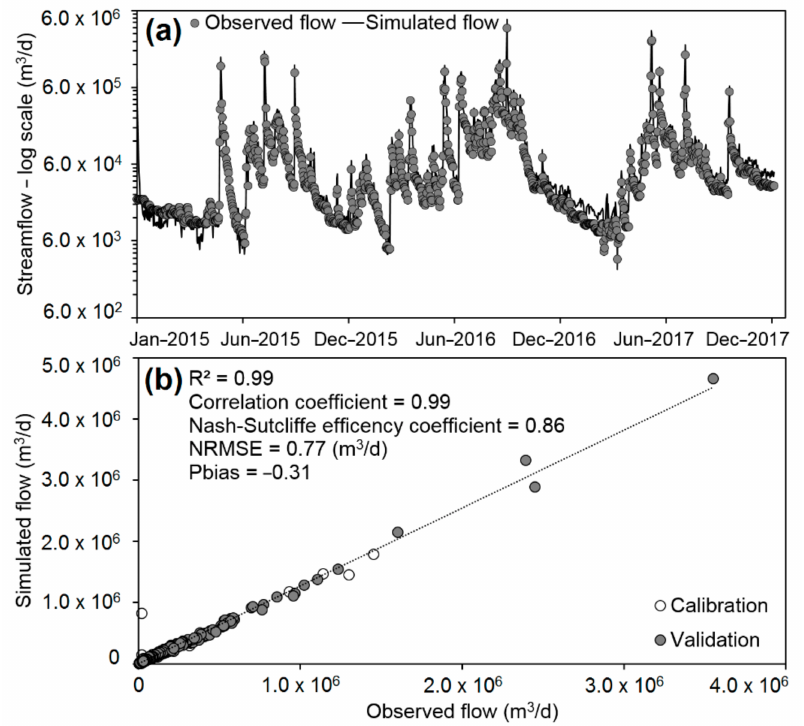
Figure 7. The comparison of the observed and simulated streamflow at Li-lin station in the Kaoping River: ( a ) the variations of stream discharge rates in logarithmic scale, and ( b ) the scatterplot of simulated and observed stream discharge rates and the associated performance statistics for the